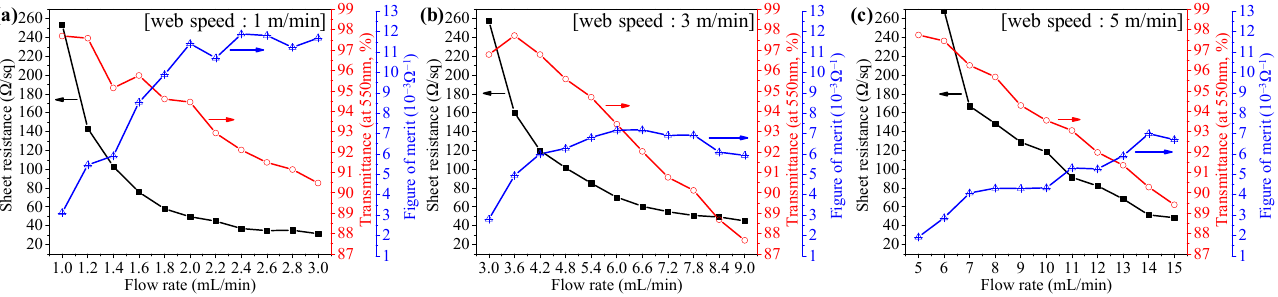
Figure 4. Sheet resistance and transmittance of Ag NW-PVP cTCFs fabricated with respect to flow rate in slot-die coating followed by full area calendering at web speeds of ( a ) 1, ( b ) 3, and ( c ) 5 m/min. Figure 5a is a schematic diagram for patterning Ag NW-PVP cTCFs in a R2R process. Slot-die coated cTCF has a low electrical conductivity due to capped PVP without calen- dering. The patterning process is performed by pressing dried cTCF using an embossed pattern roll, in which only the pattern part is pressed, as shown in Figure 5b. Embossed pattern rolls are placed on the outfeeder. In order to show that pressure was placed on the pattern area, a pressure-sensitive paper was placed on the cTCF. The LLW model of Fujifilm PRESCALE was used because a high-resolution pressure-sensitive paper was required for the small width and spacing of line patterns. As the pressure is applied to the pressure-sensitive paper, it changes from white to red. In Figure 5c, it can be seen that the pattern area appears more red due to the high pressure. The nip roll supporting the embossed pattern roll is made of a rubber material, which causes the cTCF to bend and press areas other than the pattern. However, in the enlarged picture on the right of Figure 5c, the color of the pressure-sensitive paper was not changed close to 1 mm around the pattern, due to pressure not being applied because of the bending angle of the film. For this reason, the patterning was possible, since the pattern and other parts were disconnected, which means that no current flowed. The selective calendering process can be revealed by the difference in resistance between the unpressed and pressed parts of the single line pattern from Figure 5d.